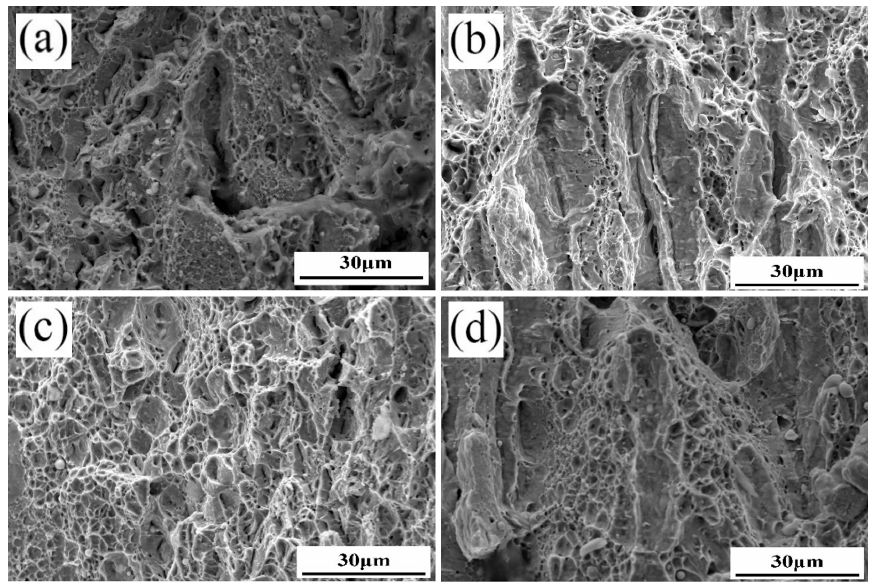
Figure 18. Fracture surfaces of two investigated steels. ( a ) 22Mn3SiNb, 800 °C–3 min, ( b ) 22MnB5, 900 °C–3 min, ( c ) 22Mn3SiNb, 800 °C–5 min, ( d ) 22MnB5, 950 °C–5 min.